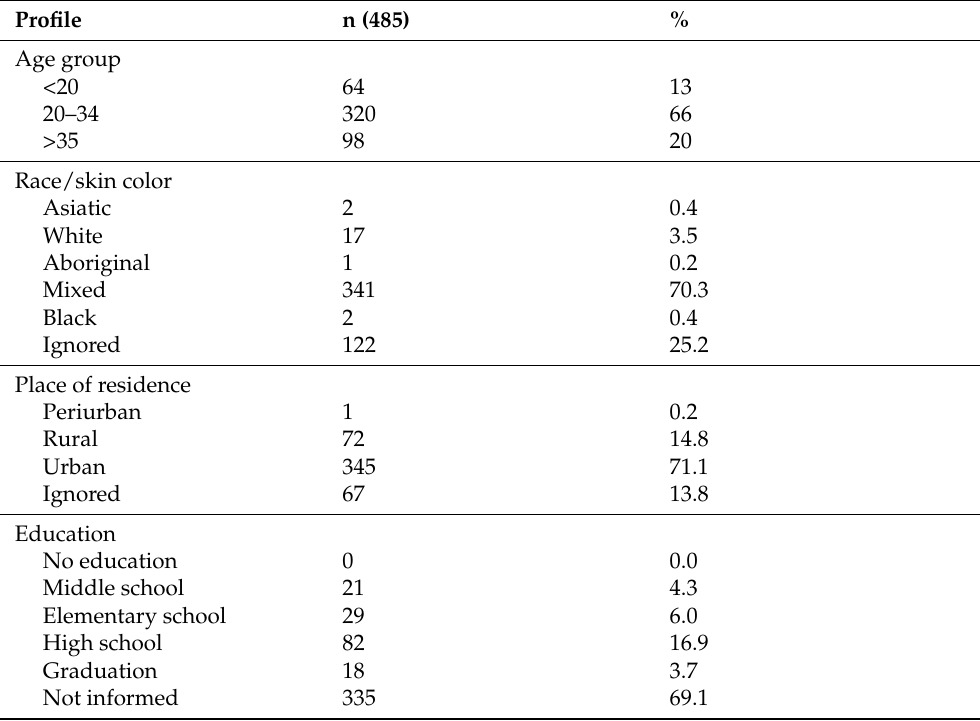
Table 2. Characteristics of pregnant and postpartum women due to COVID-19 according to sociode- mographic variables. Ceara, Brazil, 2020.